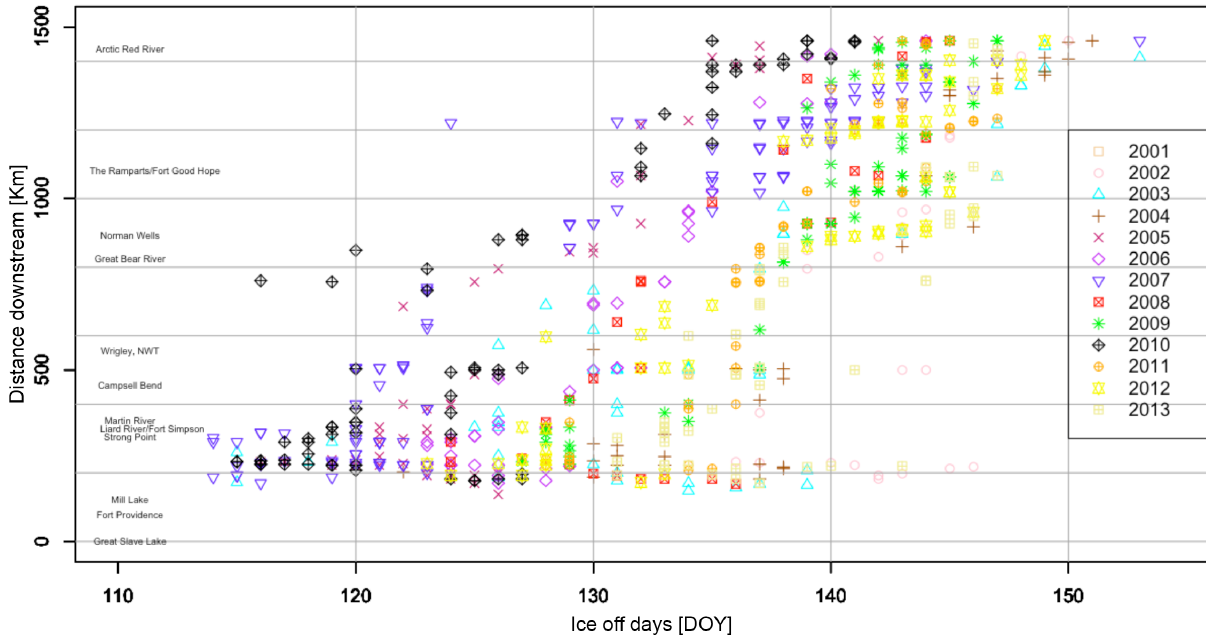
Figure 4. Compilation of all ice-off dates from 2001 to 2013 DOY (day of year) on the Mackenzie River. First ice break-up dates generally began near 325km. Ice break-up processes are more protracted just south of 325km as seen with the higher density of measurements. Near 1078km, a second channel constriction is present giving rise to two distinct ice-run patterns.